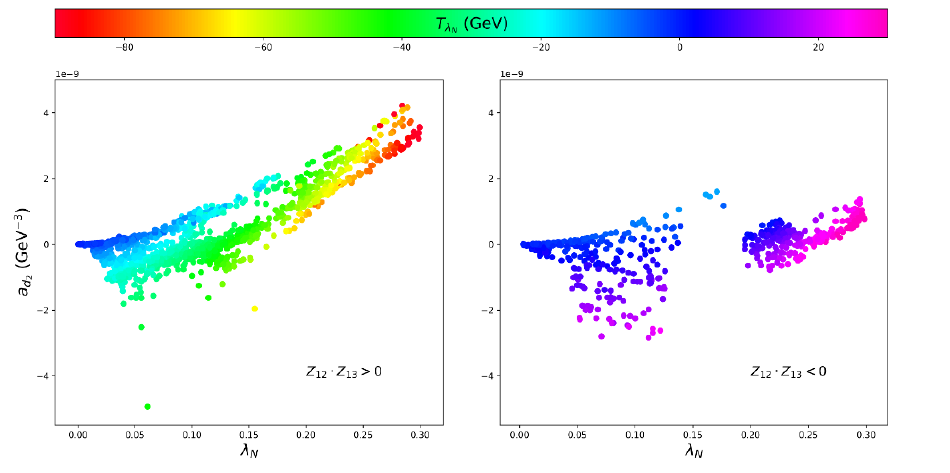
Figure 6 . Similar to (cid:12)gure 4, but projected on a d and Z 12 Z 13 < 0 case (right panel) respectively. The colors represent the values of T (cid:21) which are shown on top of the